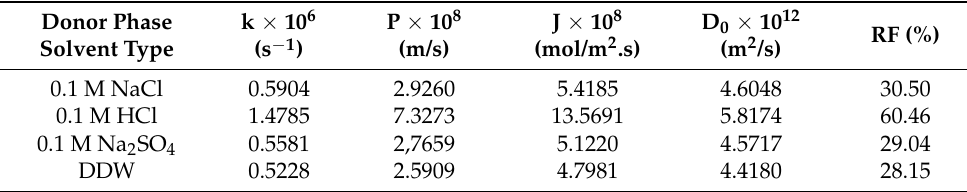
Table 3. Effect of donor phase solvent type on the transport of boron.